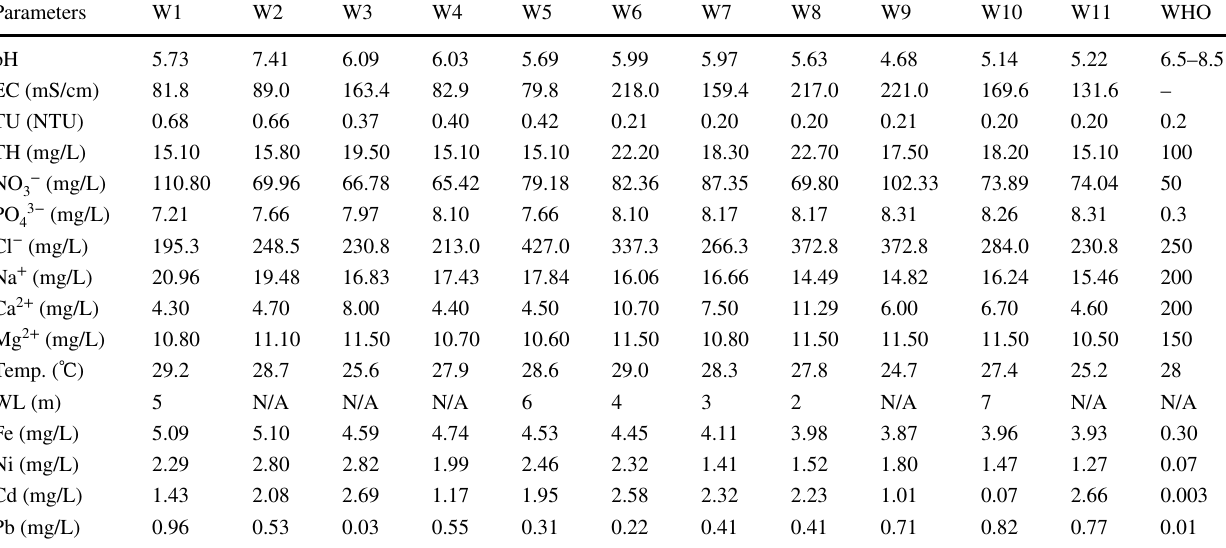
Table 2 The results of the physiochemical characteristics and heavy metals concentrations of the water samples